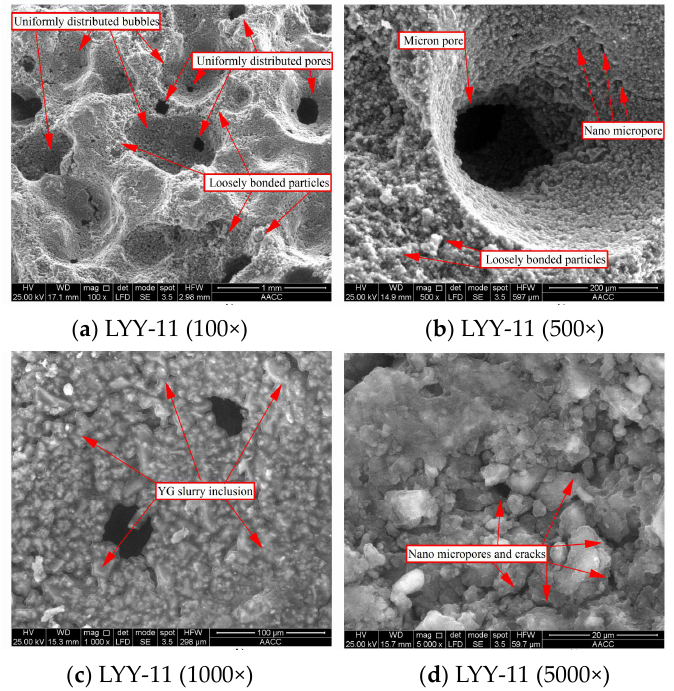
Figure 6. Scanning electron microscopy analysis of BA alkali-activated